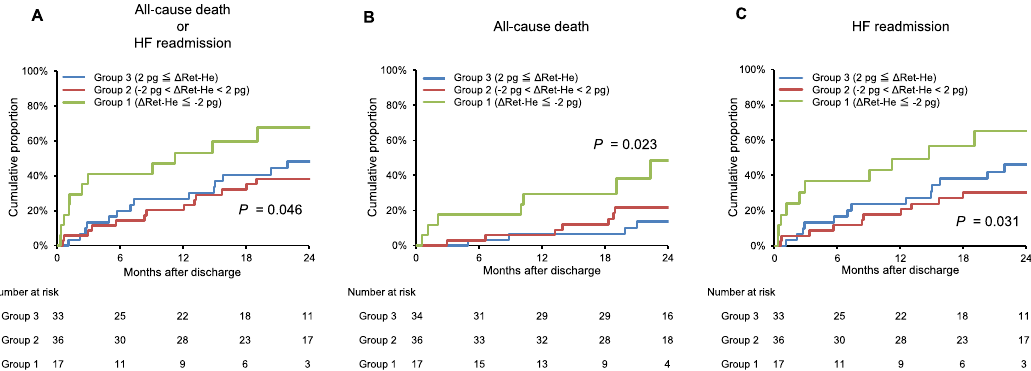
Figure 5. Survival curves for all-cause death or heart failure readmission according to a three-group classification of change in Ret-He levels between admission and discharge in HF patients. Kaplan–Meier analysis for ( A ) all-cause death or HF readmission, ( B ) all-cause death, and ( C ) HF readmission in HF patients by a three-group classification of change in Ret-He levels between admission and discharge